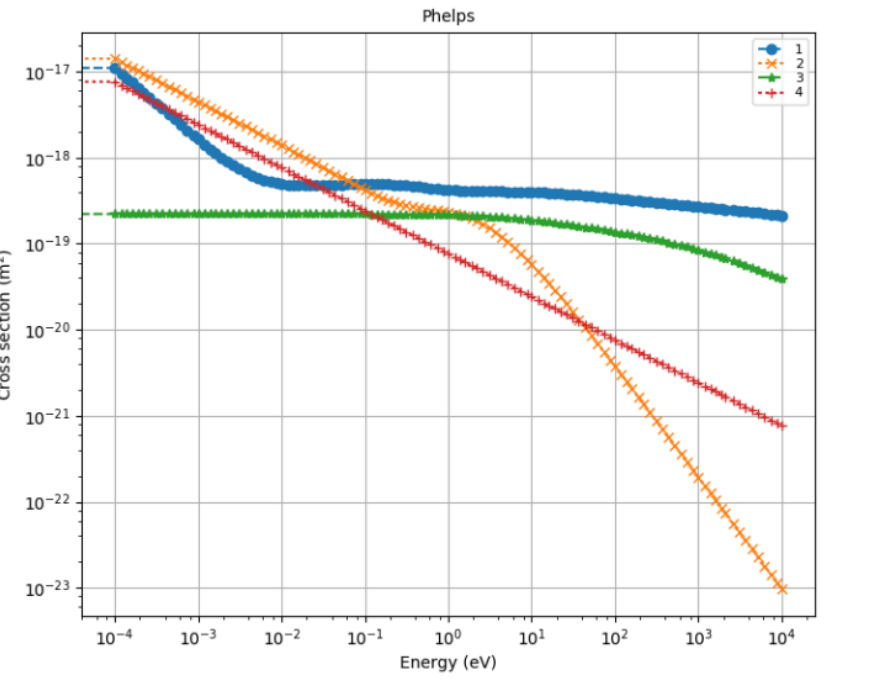
Figure 5. Ion-scattering cross-sections from the Phelps database [112]: backscattering (curve 1) and isotropic scattering (curve 2) of Ar + ion in Argon; backscattering (curve 3) and isotropic scattering (curve 4) of He + ion in